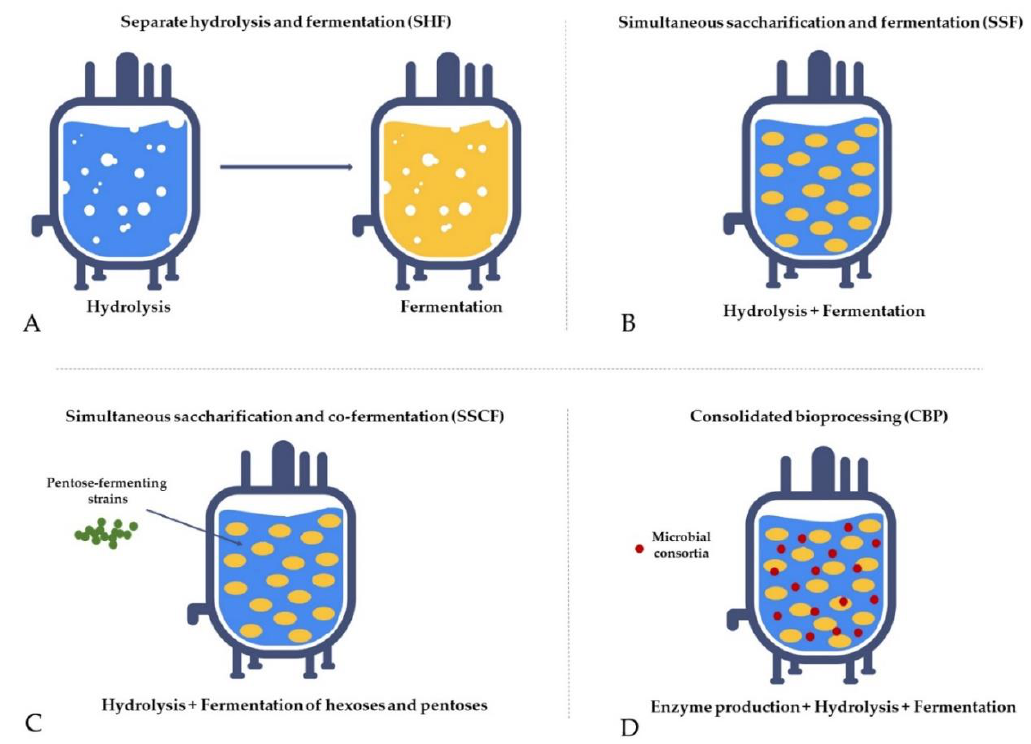
Figure 8. The fermentation strategies used to optimise the process.